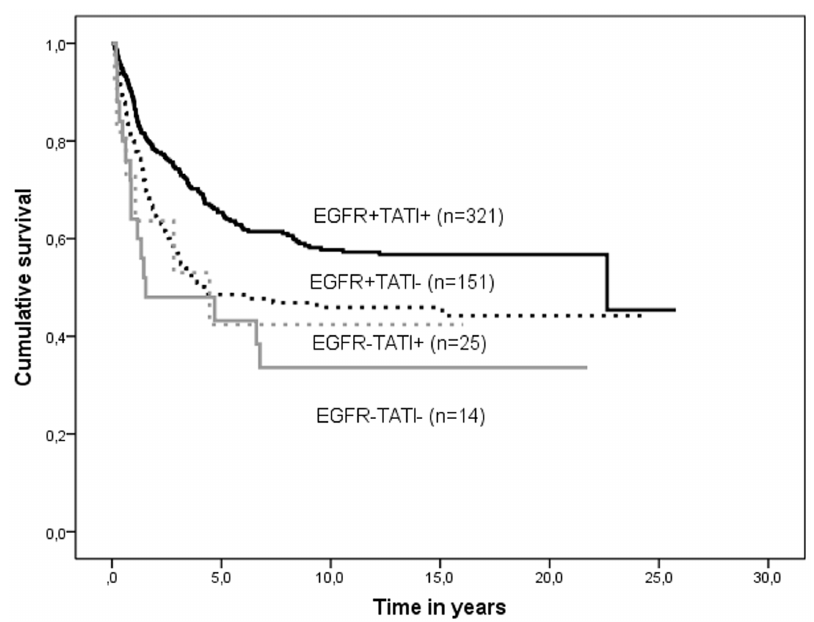
Figure 2. Survival curves of concomitant expression of EGFR and TATI/SPINK1 in colorectal cancer patients.